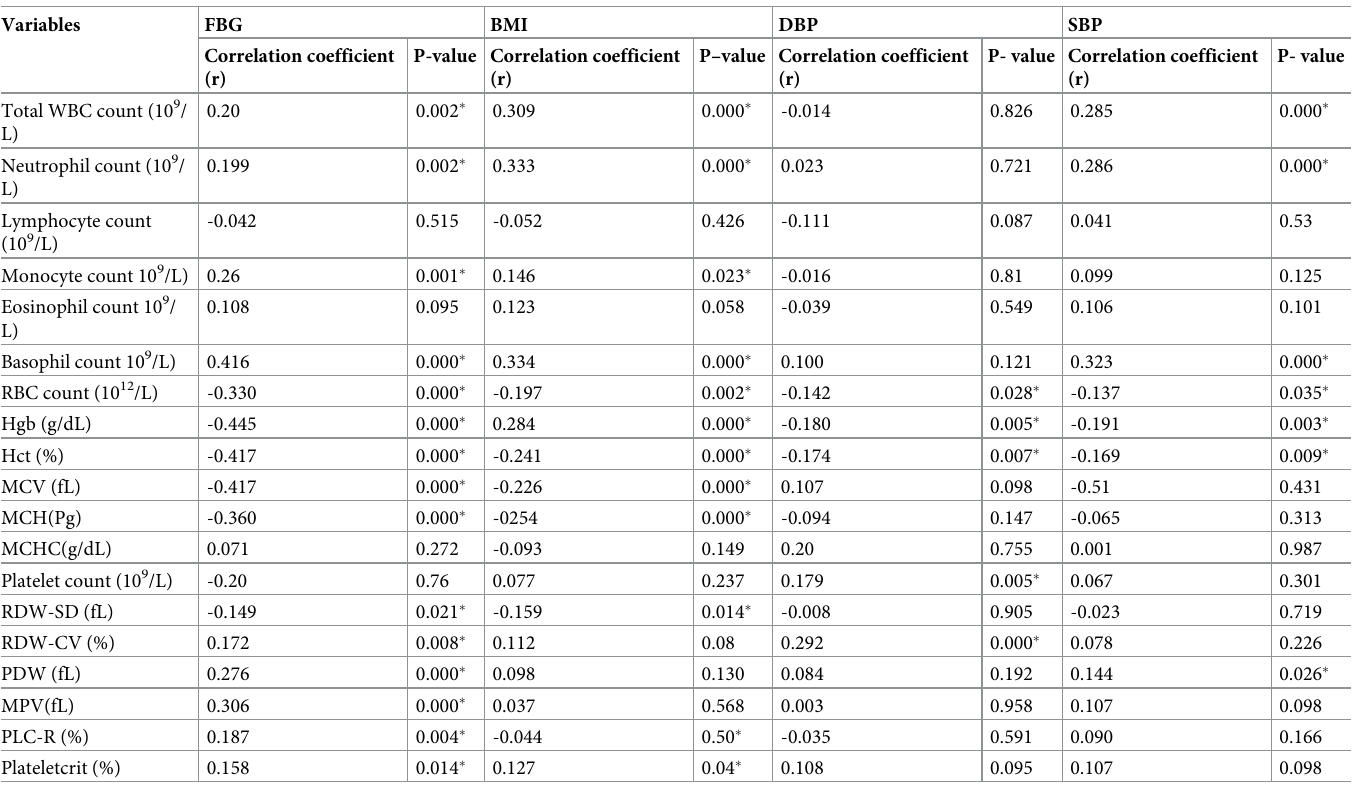
Table 4. Correlation of hematological parameters with anthropometric variables (BMI, DBP, and SBP), and FBG among T2DM patients at Dessie comprehensive specialized hospital, Northeast Ethiopia from January to June 2021 (n =